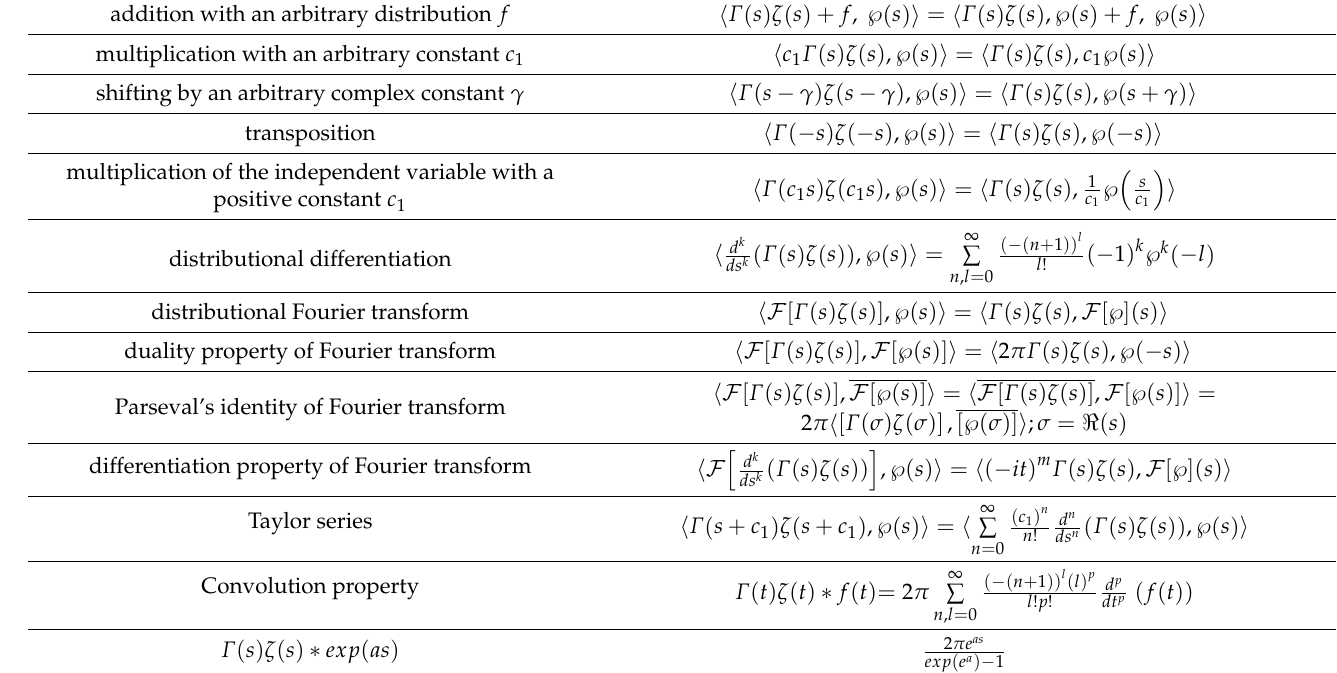
Table 3. Properties of Riemann Zeta function as a